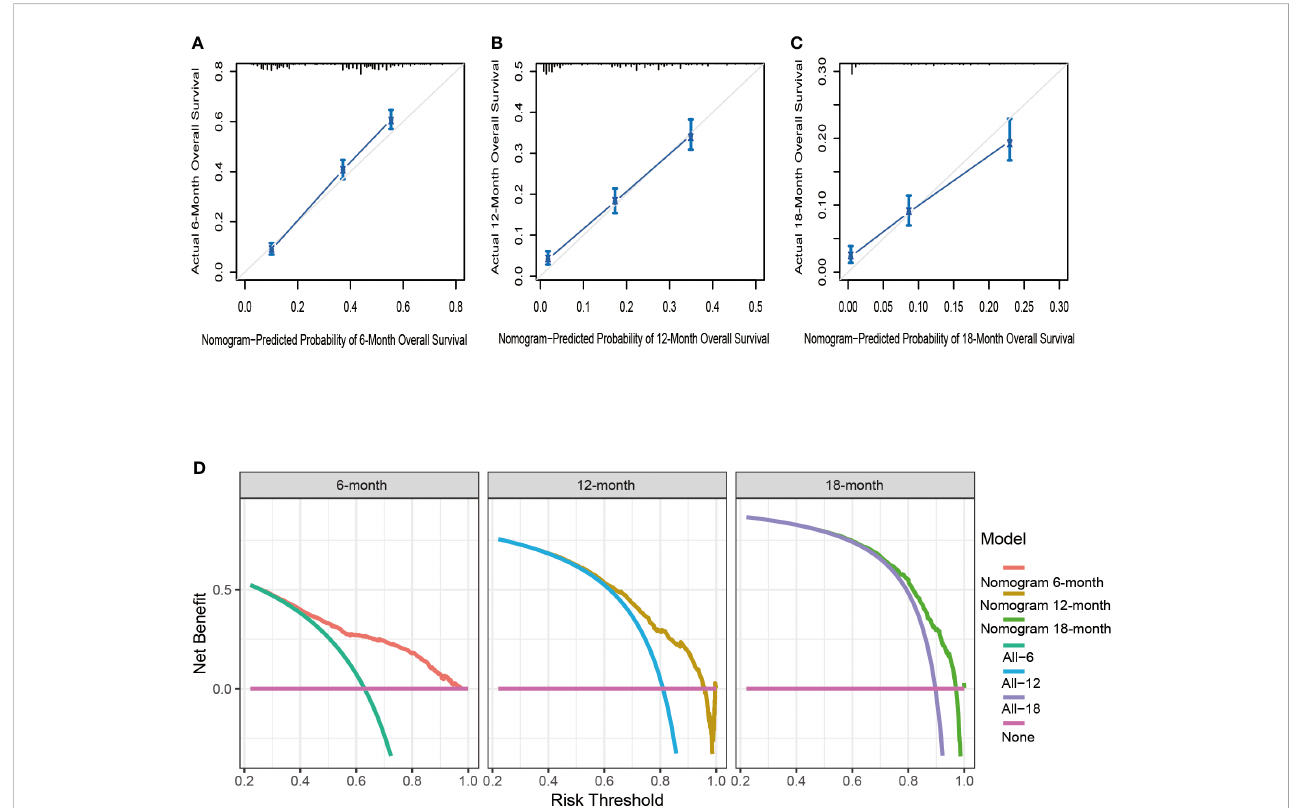
FIGURE 5 The calibration curves of the nomogram for the 6 (A) , 12 (B) , and 18 months (C) in the training set. The decision curve analysis of the nomogram for the 6, 12, and 18 months in the training set (D)